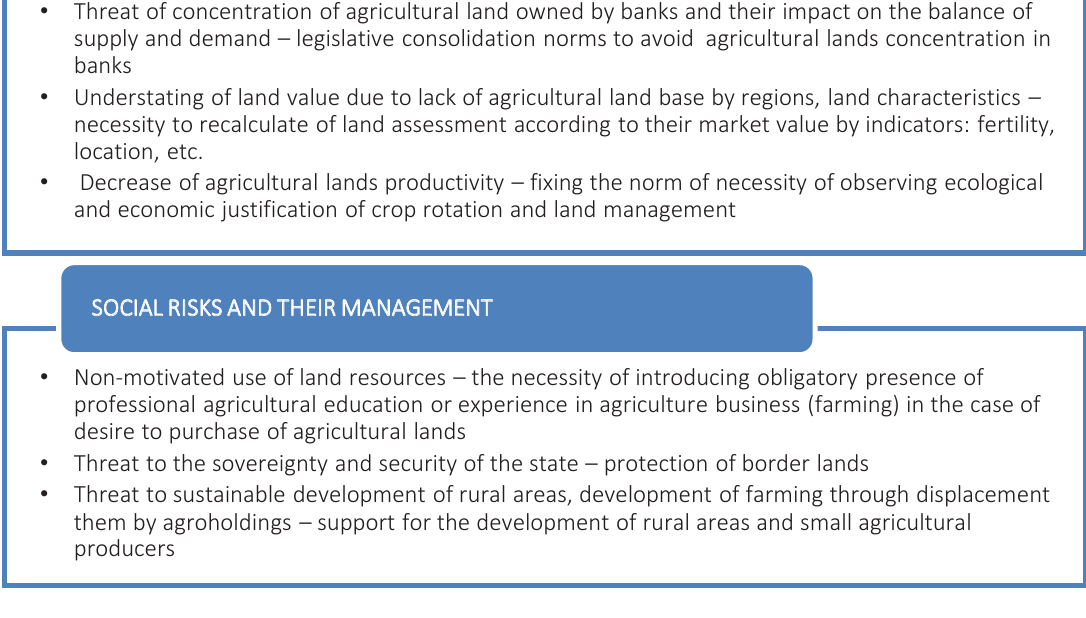
Figure 4. Risks of implementing updated land reform in